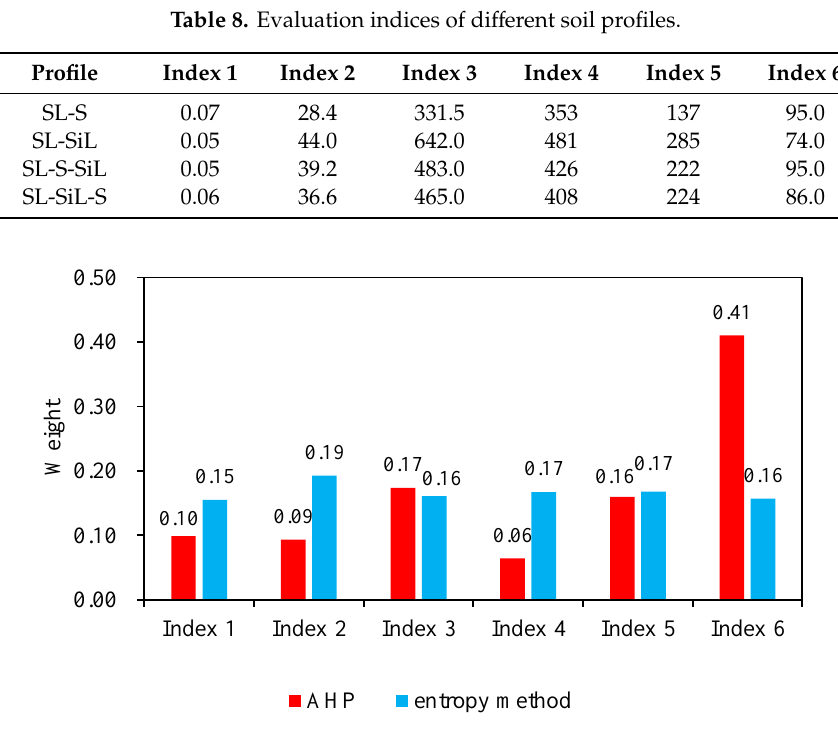
Figure 12. Weight values calculated by AHP and the entropy method.